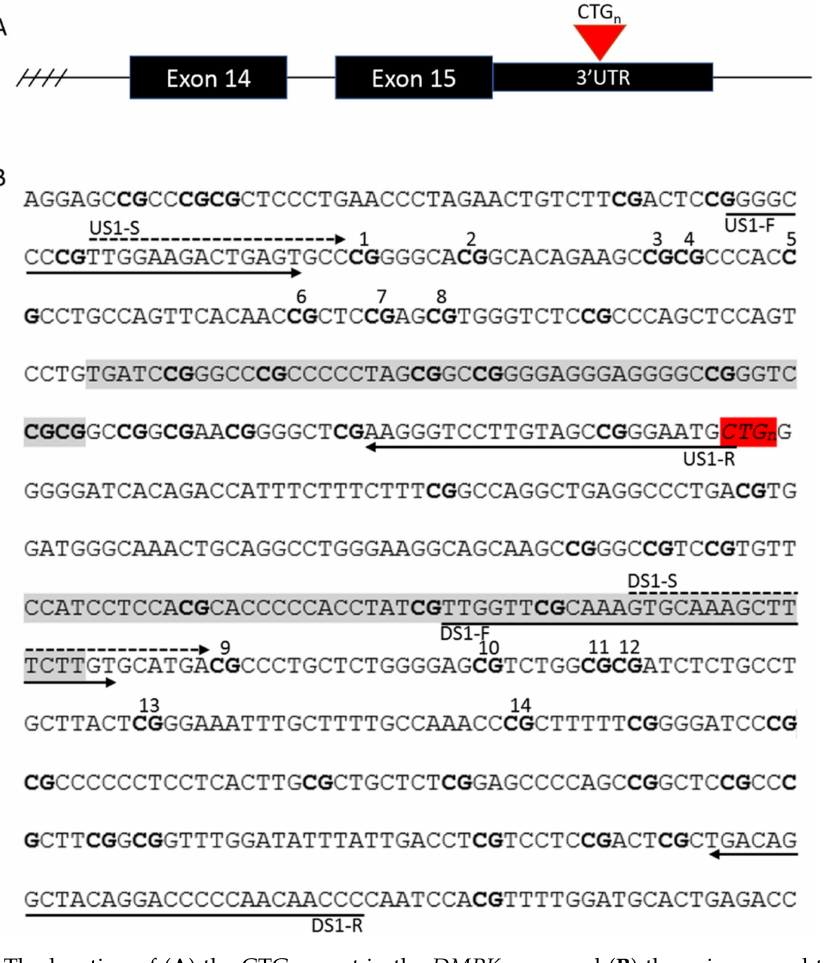
Figure 1. The location of ( A ) the CTG repeat in the DMPK gene and ( B ) the primers and the CpG sites investigated in this study. CpG sites 1–8 are located upstream and CpG sites 9–14 are located downstream of the repeat. CpG sites are marked with bold, the CTG repeat is marked with red, and CTCF binding sites flanking the repeat are marked with grey. PCR primers are marked with solid lines, and pyrosequencing primers, with dashed